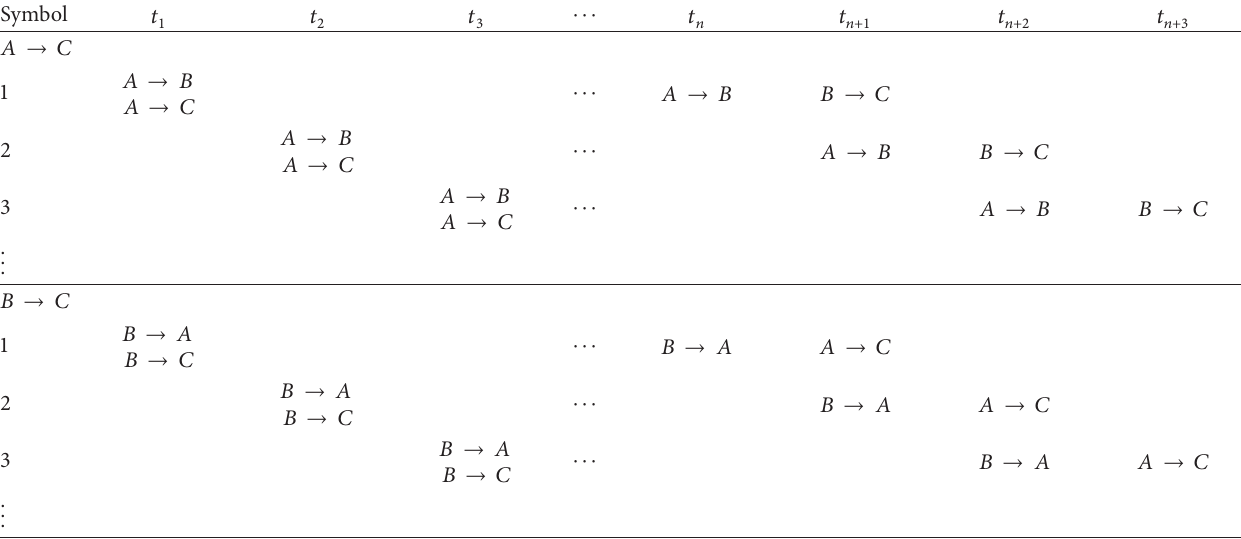
Table 1: BDF cooperative scheme based on repetition coding in the source-relay link